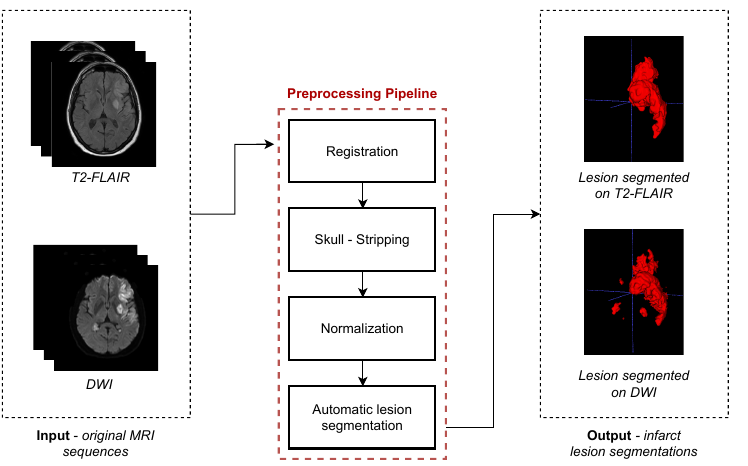
Figure 3. Image preprocessing pipeline. The same steps are repeated for each of the input MR sequences, obtaining the infarct lesion segmentation as the final output from both imaging